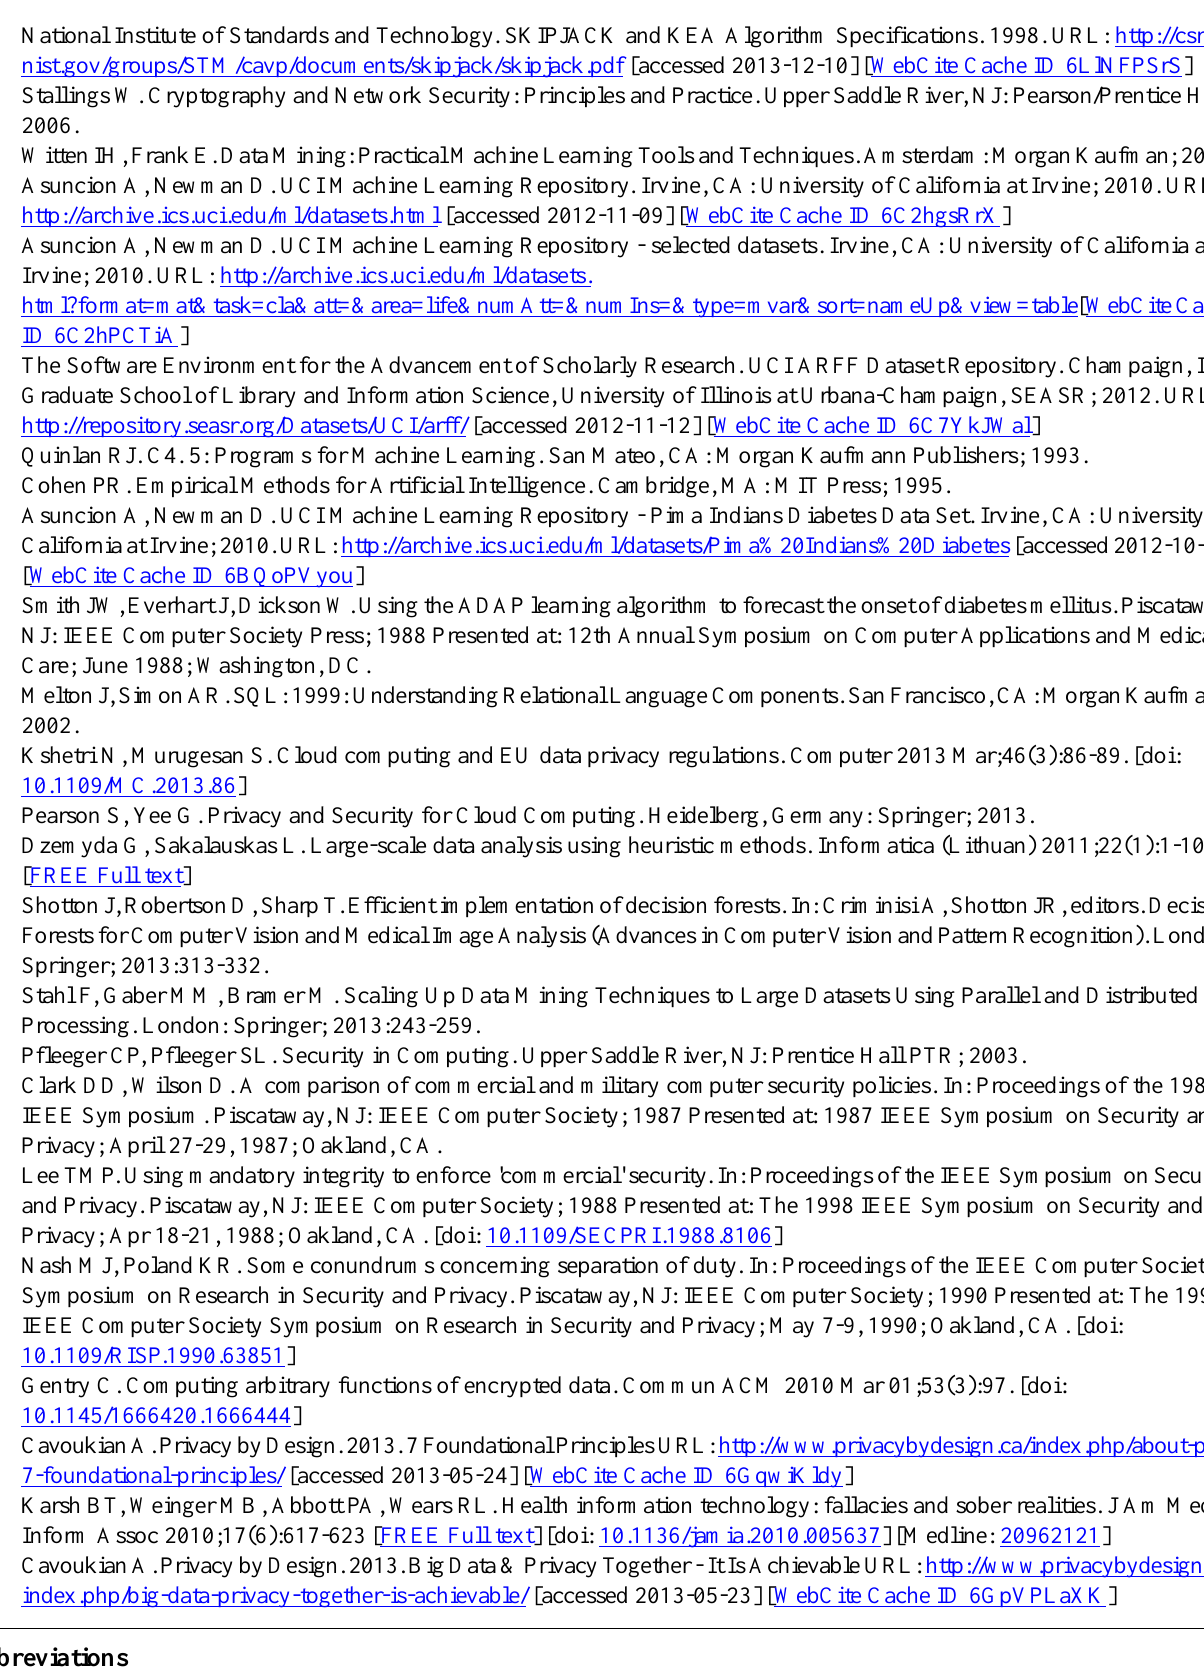
AES: Advanced Encryption Standard ARFF: Attribute-Relation File